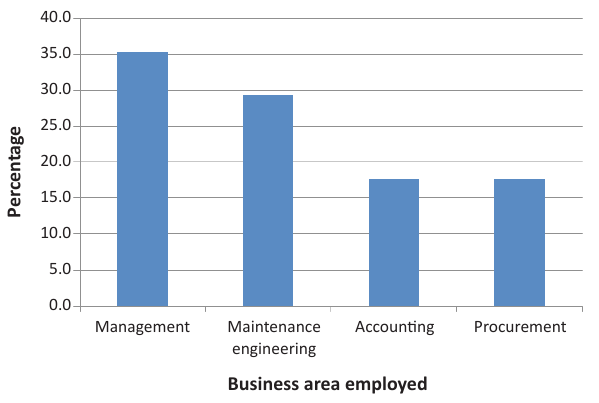
FIGURE 2: Business area of